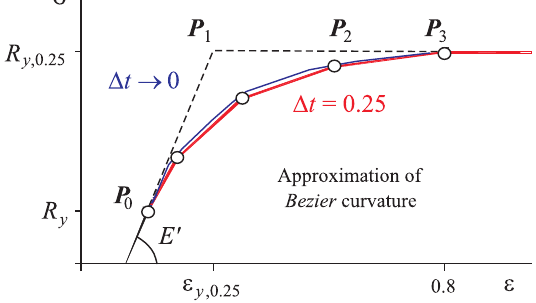
Fig. 3. Approximation of plastic shear strains zone by 0.25 steps